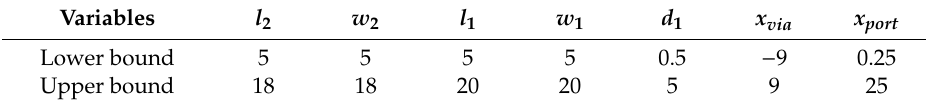
Table 2. Explored ranges of the design variables (all sizes in mm).